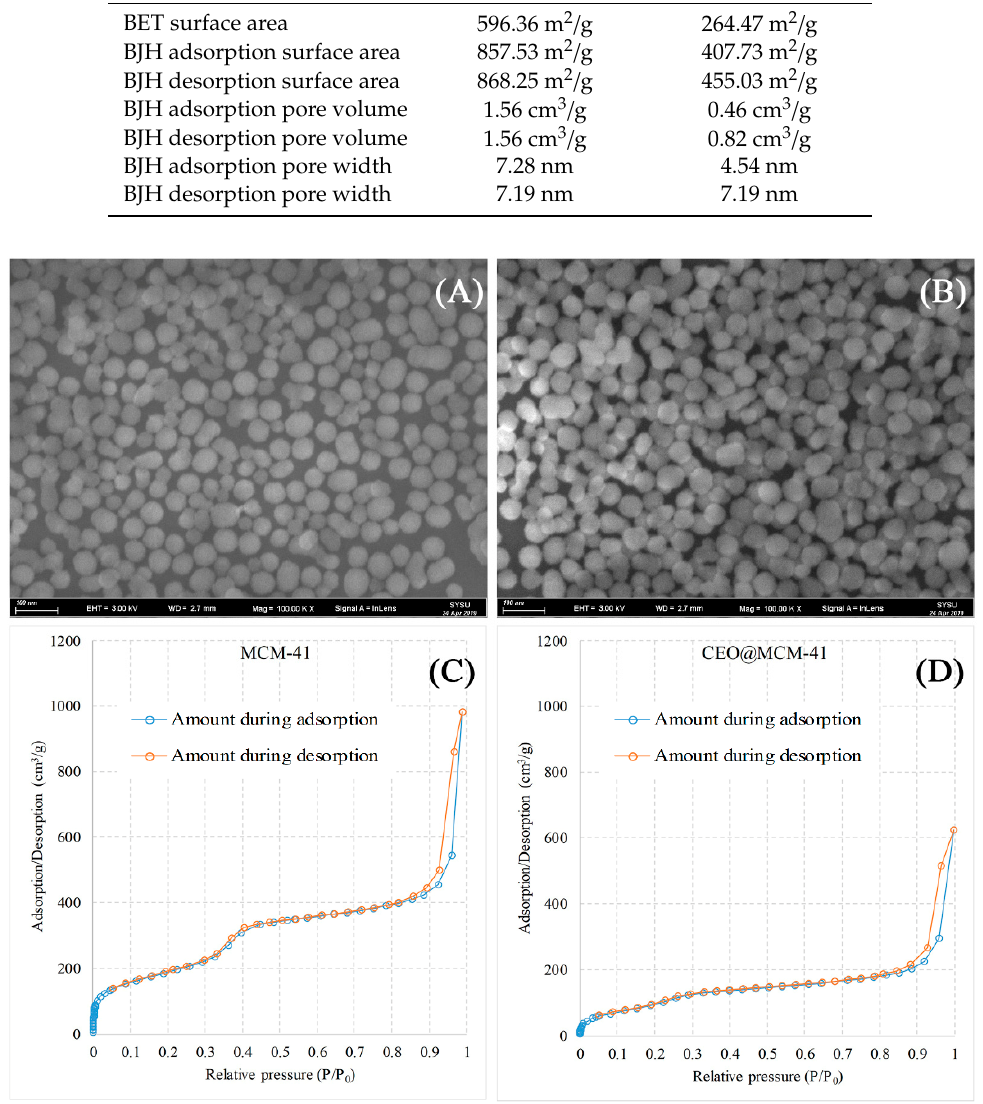
Figure 1. Scanning electron microscope images of ( A ) MCM-41 and ( B ) CEO@MCM-41 particles,